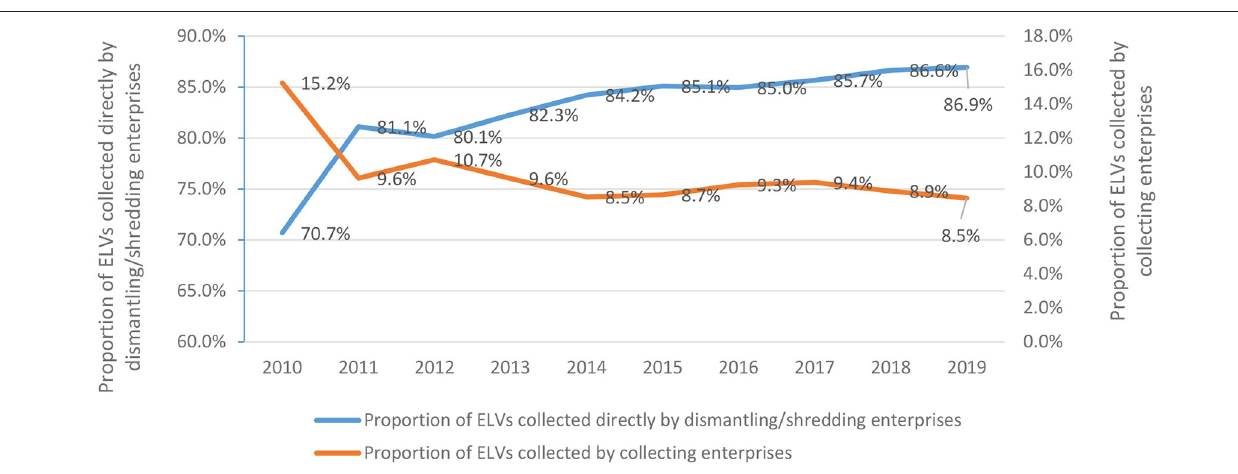
metals, which was far below the vehicle owners’